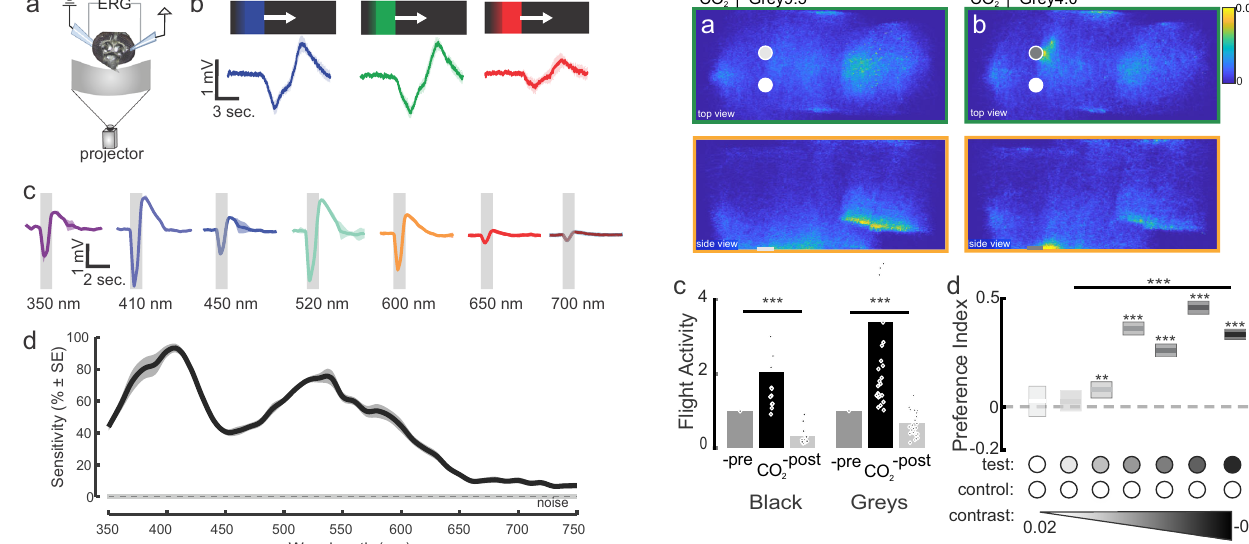
observer)(Fig. 6a, b). Across a range of gray contrast levels, the 660 nm object was signi fi cantly more attractive to Ae. aegypti than the gray objects (Fig. 6a, c, e; Kruskal – Wallis test: Chi- square = 149.75, df = 6, P < 0.0001). As the gray objects became darker, however, they became more attractive to the mosquitoes, and the strong preference for the 660 nm object decreased (Fig. 6e). The attractiveness of the 660 nm object equaled that of the darkest gray and black objects (Fig. 6e; one-sample t -test: P = 0.07 and P = 0.08 for the darkest gray [gray 1.5] and black objects, respectively). We then determined which contrast of a 510 nm object (green to human observer) matched the attraction to the 660 nm object. For this purpose, we used the darkest gray object that was equally attractive as the 660 nm object and tested it against objects with dominant wavelengths of 510 nm but differing in their background contrast (Fig. 6b). The dark gray object was signi fi cantly more attractive than most 510 nm objects, but the darkest 510 nm object elicited the same level of attraction (Fig. 6f; preference index = − 0.01; one-sample t -test: P = 0.66). To determine whether Ae. aegypti mosquitoes can discriminate between objects of different dominant wavelengths but similar levels of apparent contrast, we tested attraction to the 660 nm vs. the darkest 510 nm object (Fig. 6g, h). During exposure to CO 2 , mosquitoes were strongly attracted to 660 nm but not the dark 510 nm object (Fig. 6g, h; one-tailed t -test: P < 0.0001). We also determined whether mosquitoes could discriminate between NATURE COMMUNICATIONS| (2022) 13:555